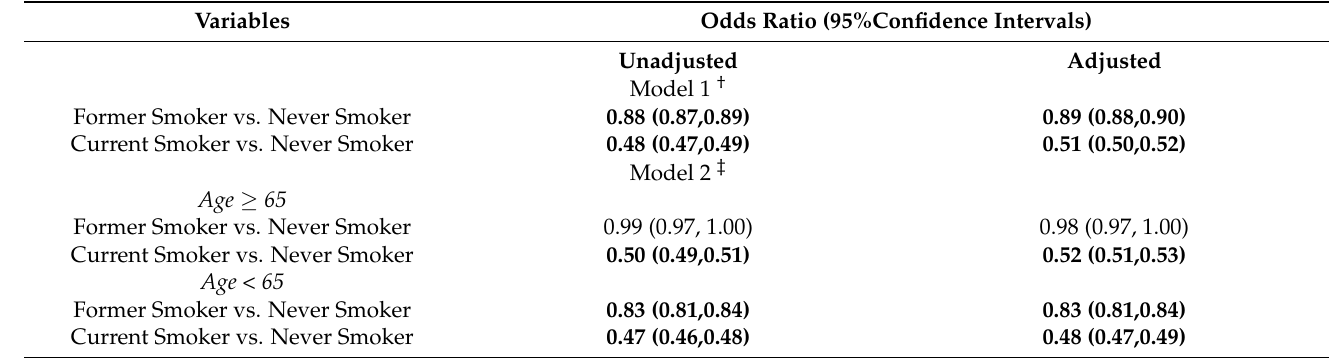
Table 4. Association between imputed smoking status and COVID-19 positivity stratified by age for imputed